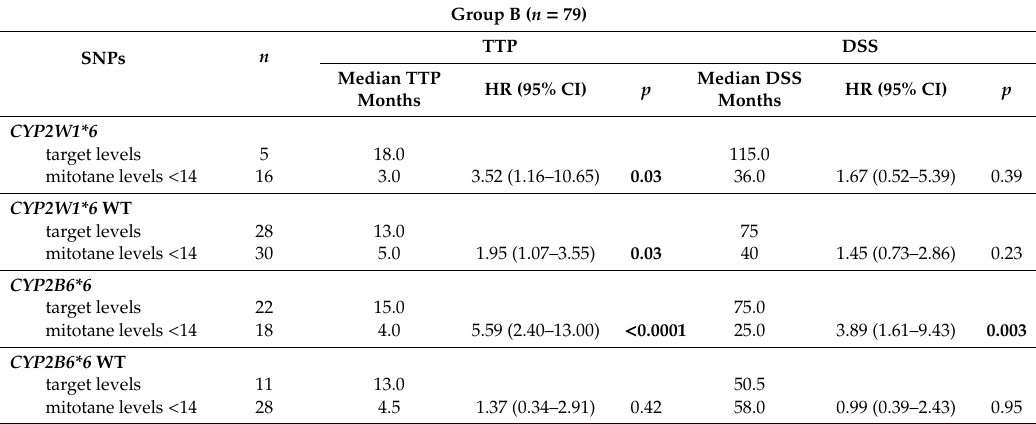
Table 6. Time to progression and disease-specific survival for patients with CYP2W1*6 or CYP2B6*6 correlating with the achievement of the mitotane target levels in group